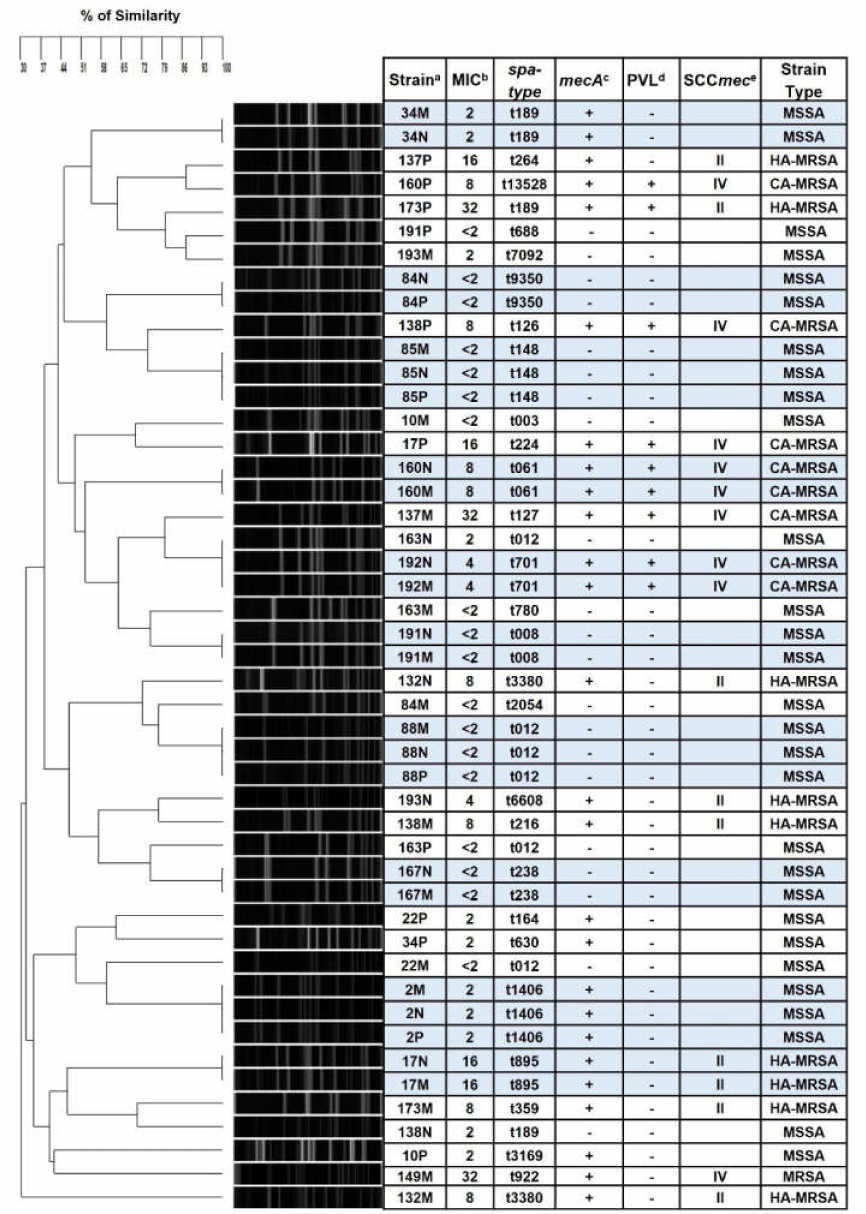
Figure 1. SmaI -PFGE dendrogram comparing Staphylococcus aureus strains isolated from carriers and their contaminated mobile phones. Carrier number and site, oxacillin MIC, spa -type, mecA and PVL genes detection, and SCC mec for each strain are shown. a Carrier number/site: M = mobile phone; P = pharynx; N = nose. b Oxacillin MIC in µ g/mL. c – not detected; + detected. d lukS-PV/lukF-PV genes which encode PVL was detected, -not detected; + detected. e SCC mec type was tested only when the strain had MIC ≥ 4 µ g/mL. Blue cells: strains from the same carrier that are identical by PFGE and spa